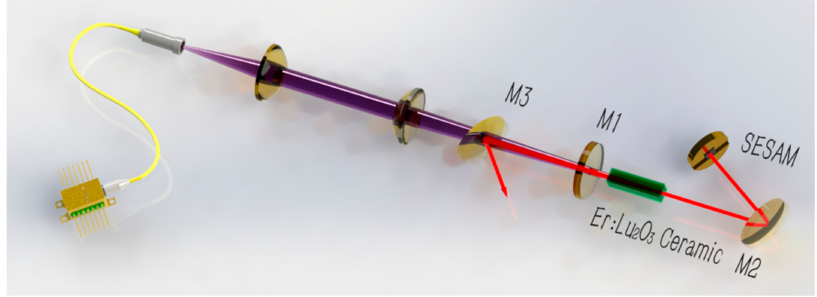
Figure 1. Experimental setup for the passively Q-switched Er:Lu 2 O 3 ceramic